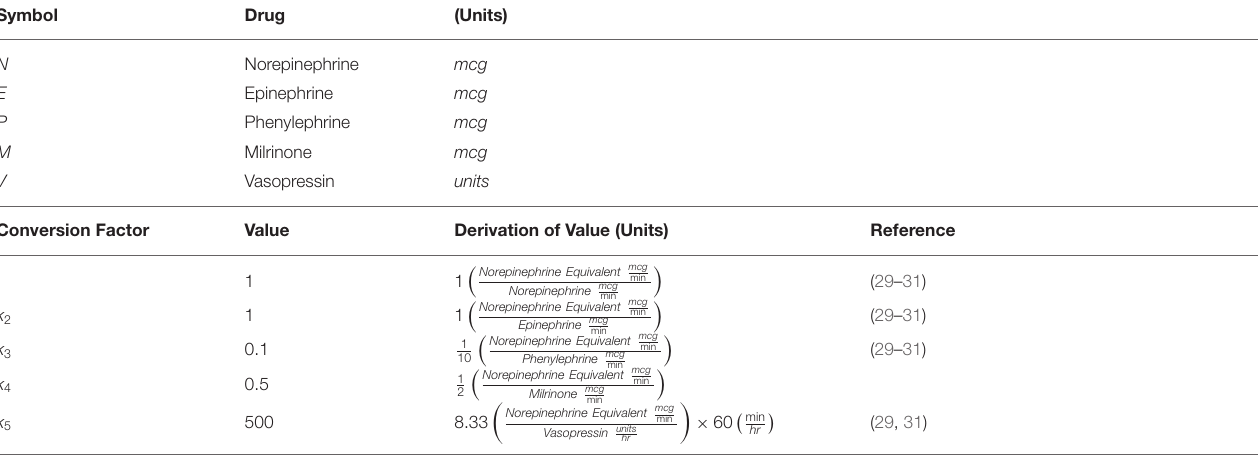
TABLE 3 | Equation terms and derivation of conversion factors for vasopressor-inotrope equivalent dose. Symbol Drug